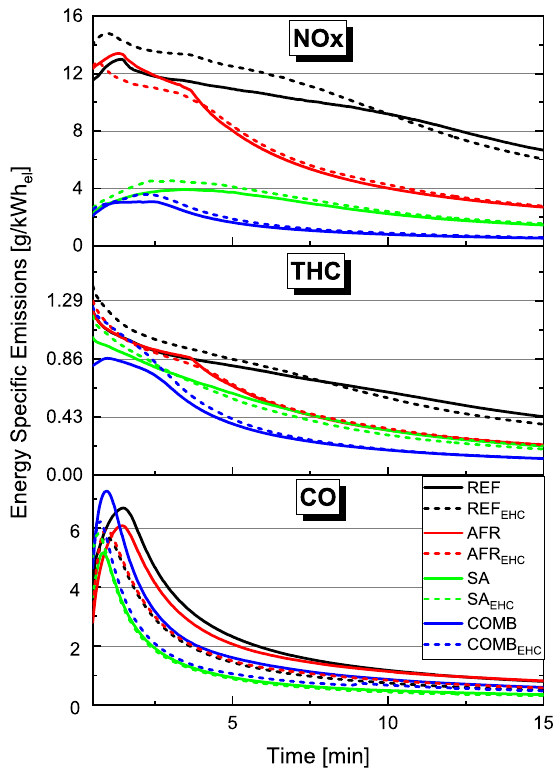
Figure 10. Specific emission masses with respect to the electrical energy